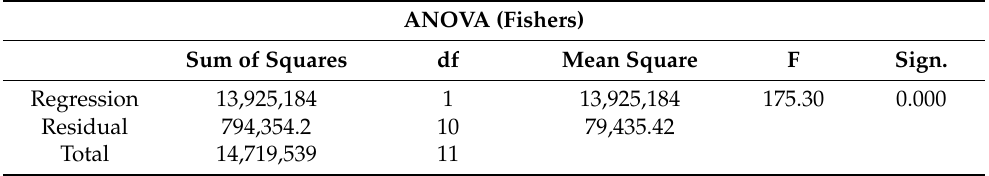
Table 4. ANOVA of the fishers’ linear regression model.